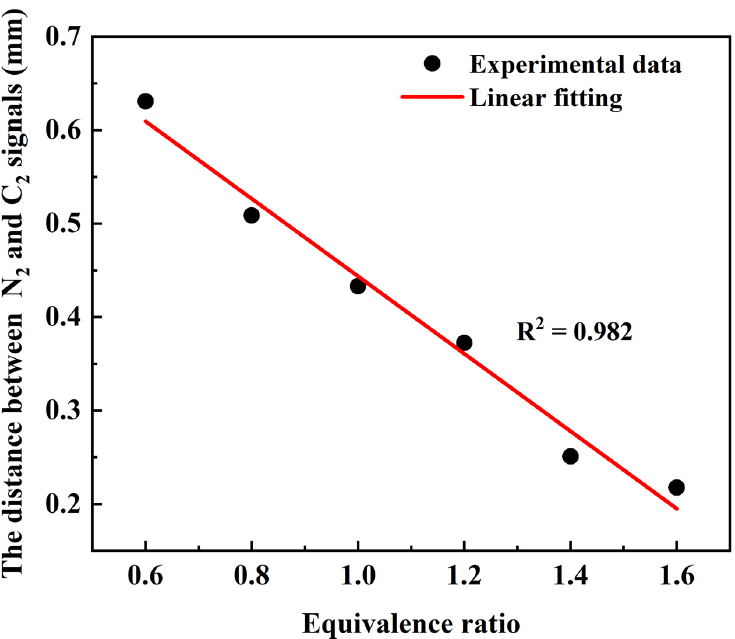
Figure 8. Calibration curve of the distance between N 2 (337 nm) and C 2 (516.5 nm) signals as a function of equivalence ratio.